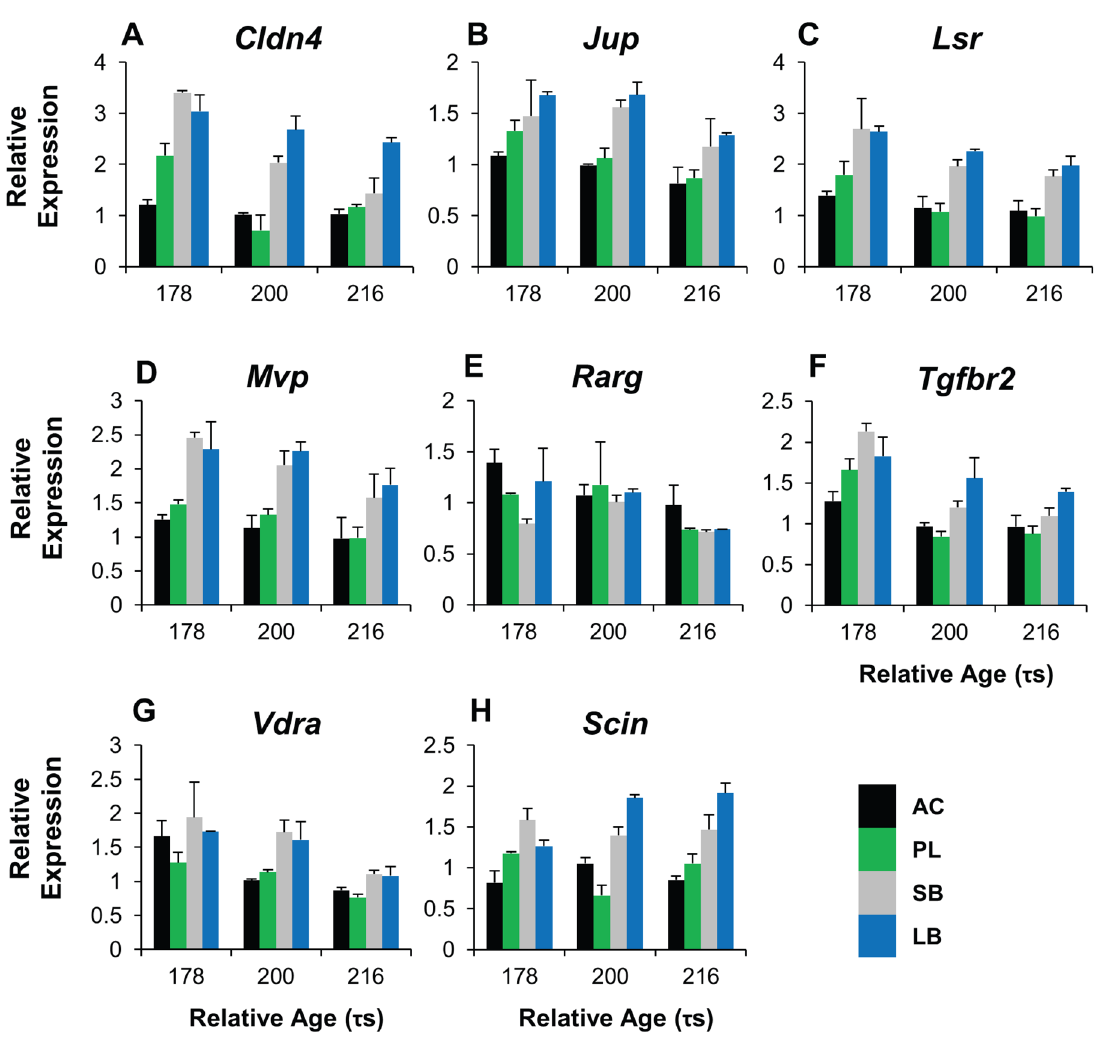
S2 Figure. Relative expression of selected craniofacial candidate genes. Relative expression of 12 candidate genes with characterized craniofacial expression during zebrafish development (ZFIN website) in the head of SB, LB, PL and AC at three time points in development. In the transcriptome data all of the genes had shown higher expression in SB at 200 τ s. The expression is normalized to the geometric means of two craniofacial reference genes ( ACTB and IF5A1 ). Expression is relative to a replicate of AC morph at 200 ( τ s), set to one. Error bars represent standard deviation calculated from two biological replicates and each biological replicate contains homogenate of six